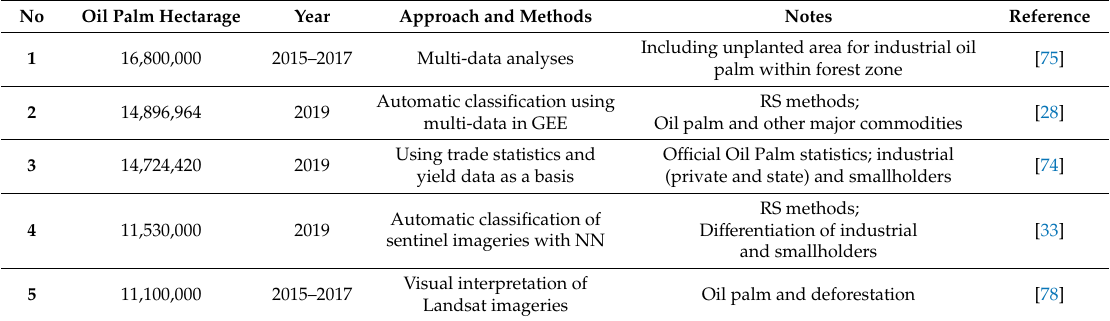
Table 2. Published estimates of the total area of oil palm in